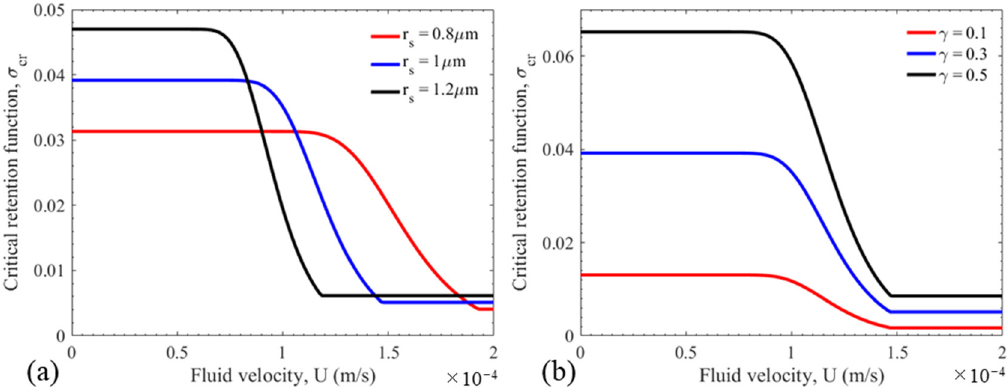
Figure 5. Sensitivity of the critical retention function with respect to the coefficient of variation of the pore size distribution ( a ) and the ratio of oil to water viscosity ( b ).